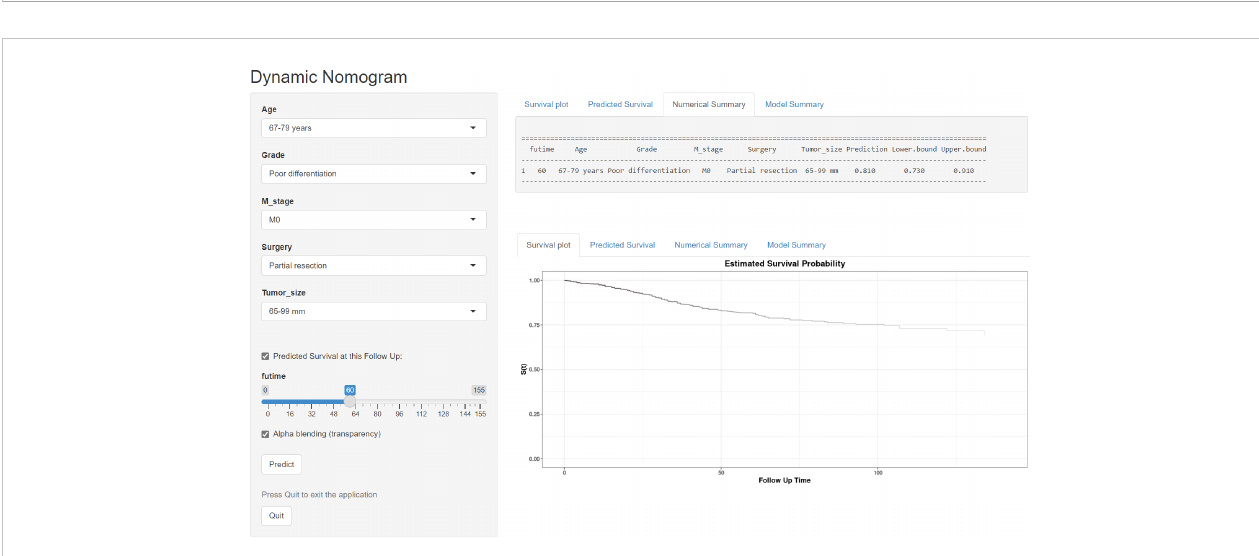
FIGURE 9 Operation interface of the web-based calculator after inputting a patient ’ s age, M stage, grade, surgery, and tumor size on the web and ascertaining the time point of the survival